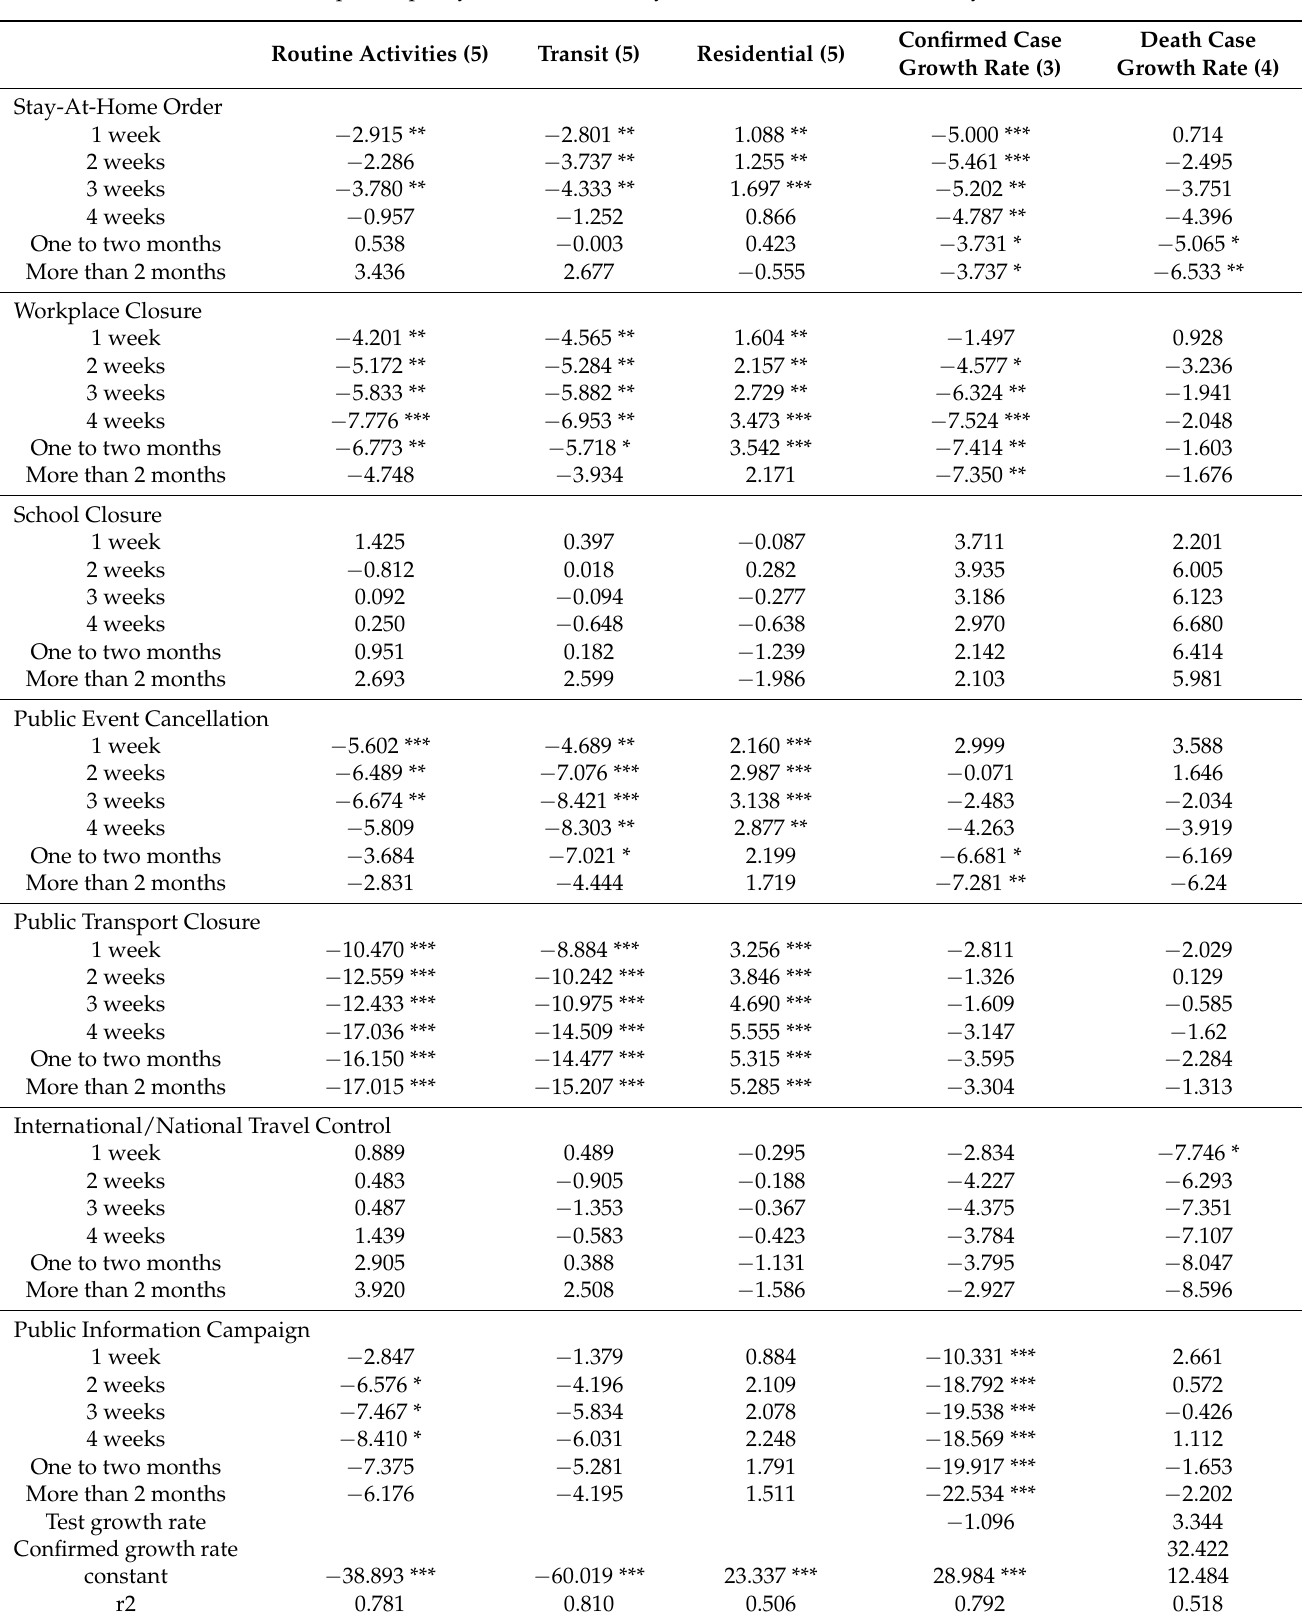
Table 2. The impact of policy on human mobility, COVID-19 cases, and mortality of